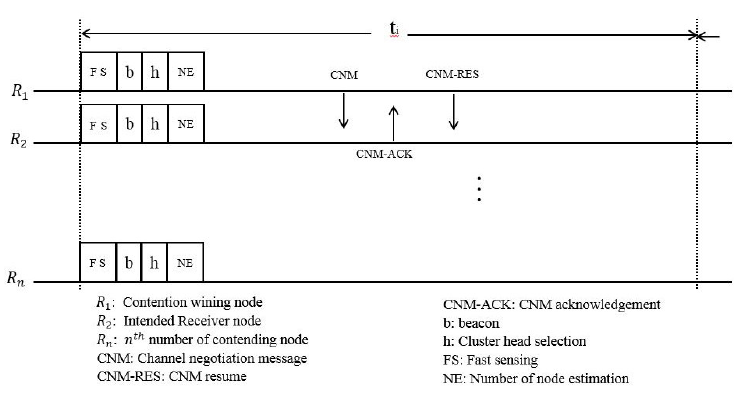
Figure 10 . Channels with default time slots.